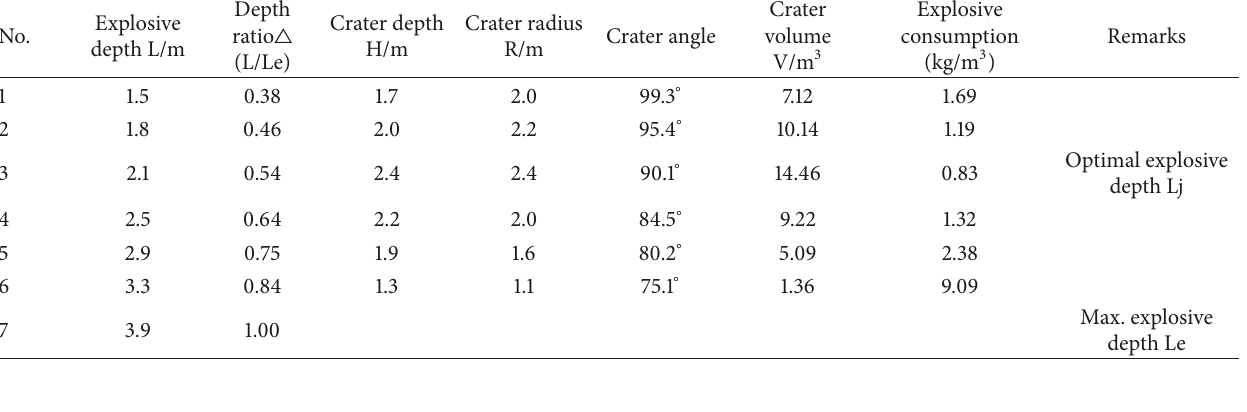
Table 1: Field experiment results.